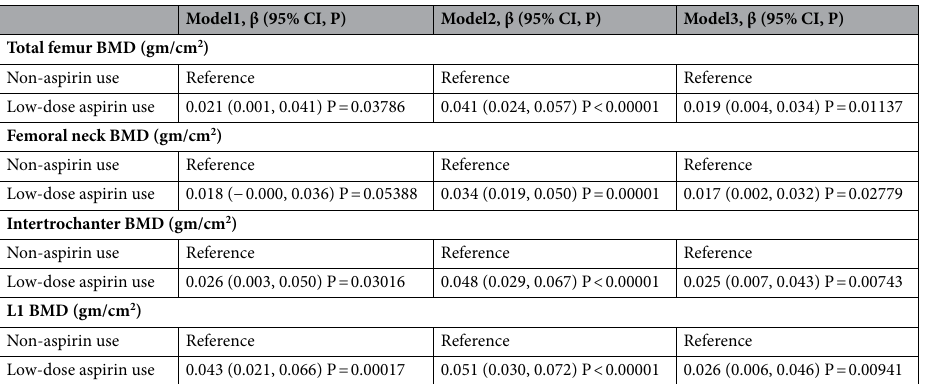
Table 5. Associations between low-dose aspirin use and bone mineral density. Model 1 no covariates were adjusted. Model 2 age, gender, and race were adjusted. Model 3 Gender, Age, Race, Heart attack, Vigorous work activity, BMI, Hba1c, Education level, Ratio of family income to poverty, Fractures, Anti-osteoporotic, Prednisone or Cortisone, HS C-Reactive Protein, Smoking status, Serum Creatinine, Serum Uric acid, Alcohol consumption were